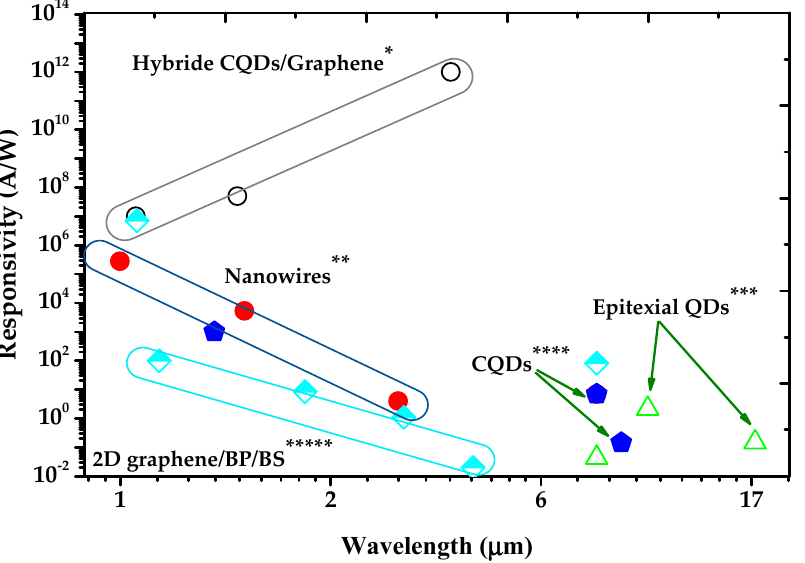
Figure 12. A summary of the responsivity of infrared photodetectors based on different nanostructured materials versus the detection wavelength [10,39–41] *; [36–38] **; [28–31] ***; [33–35] ****; [153,157–159] *****.